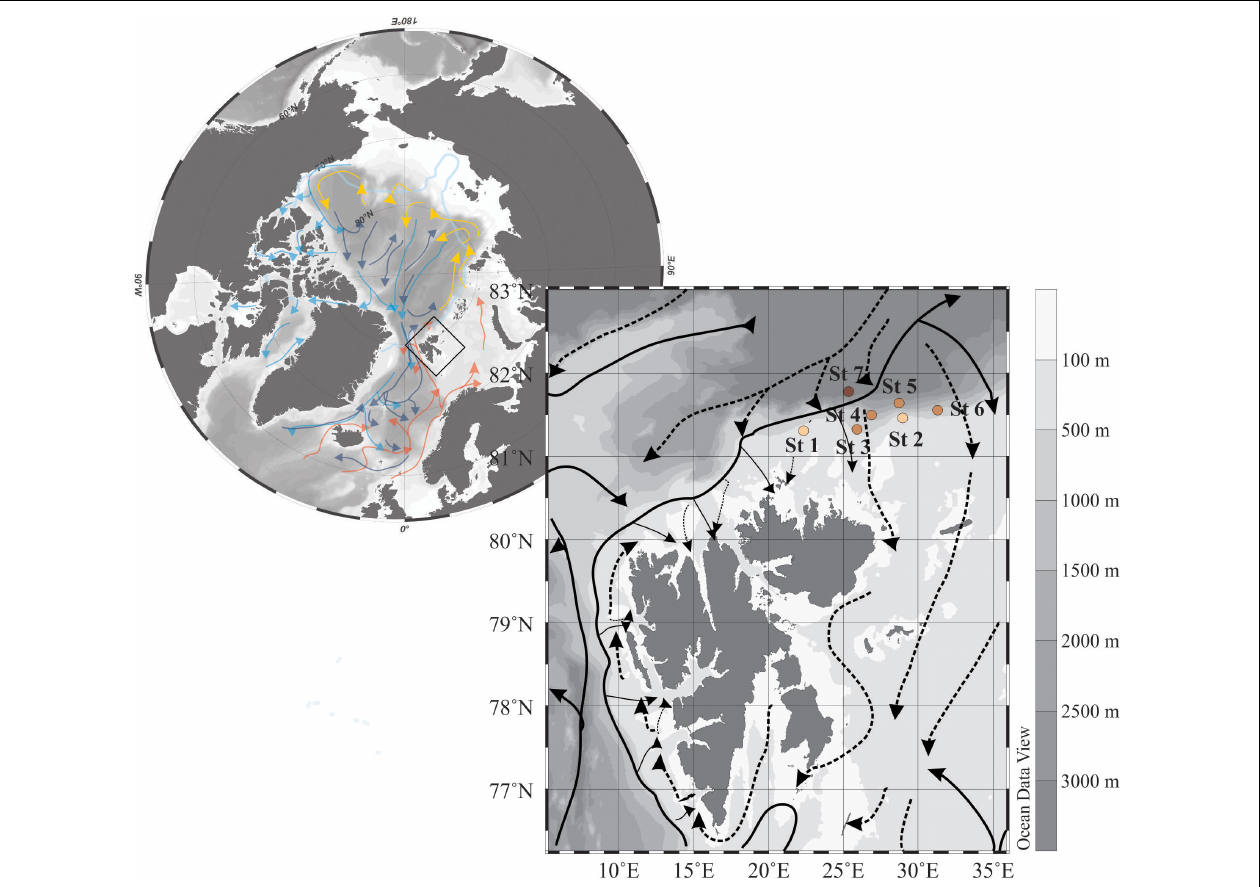
FIGURE 1 | Map of the Arctic Ocean with warm and cold surface, intermediate and deep waters in red, blue, yellow, and dark blue arrows [modified from Anderson and Macdonald (2015). Detailed surface Atlantic (solid line) and Arctic (dashed line) currents from Hop et al. (2019)].Sea ice extent on September 2018 in light blue, and study area framed in black. Zoom in the study area with the sampling